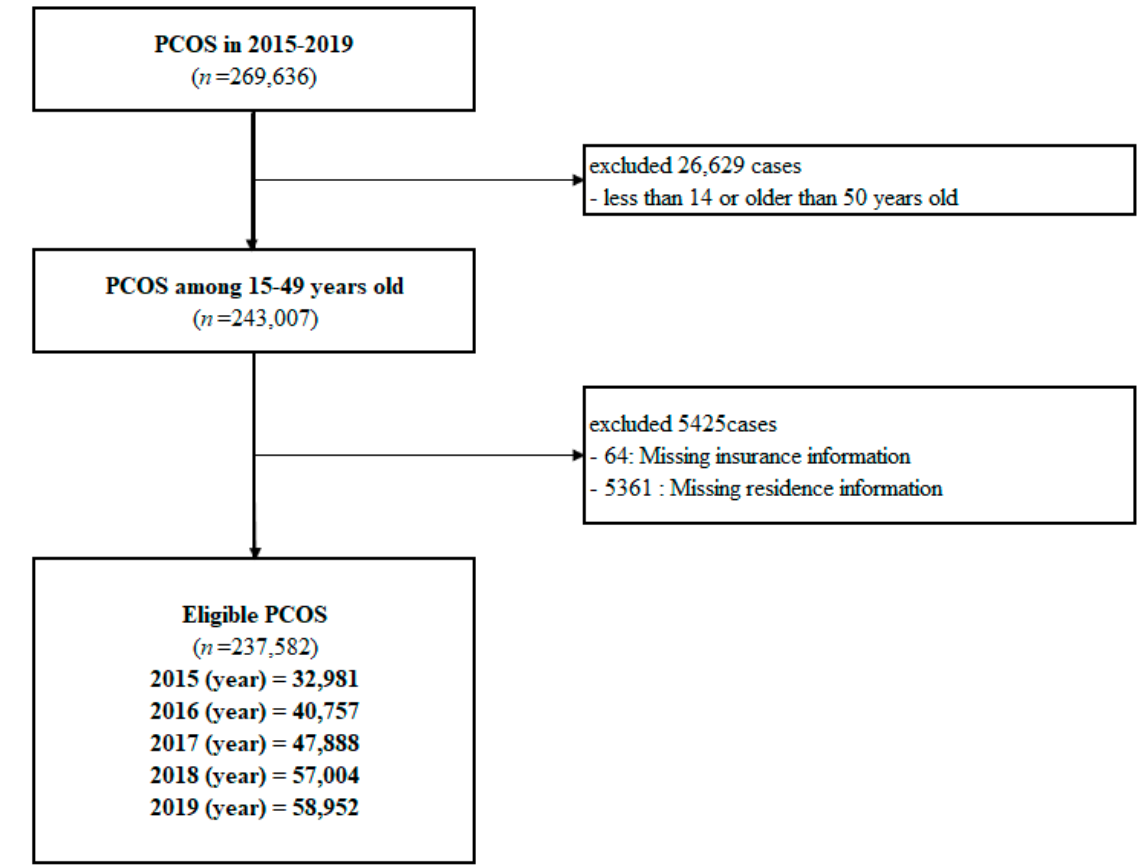
Figure 2. Flow chart of participant